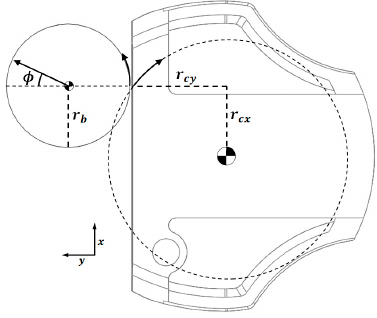
Figure 1. Gear effect for a deep center of gravity (CG) putter when impacted towards the